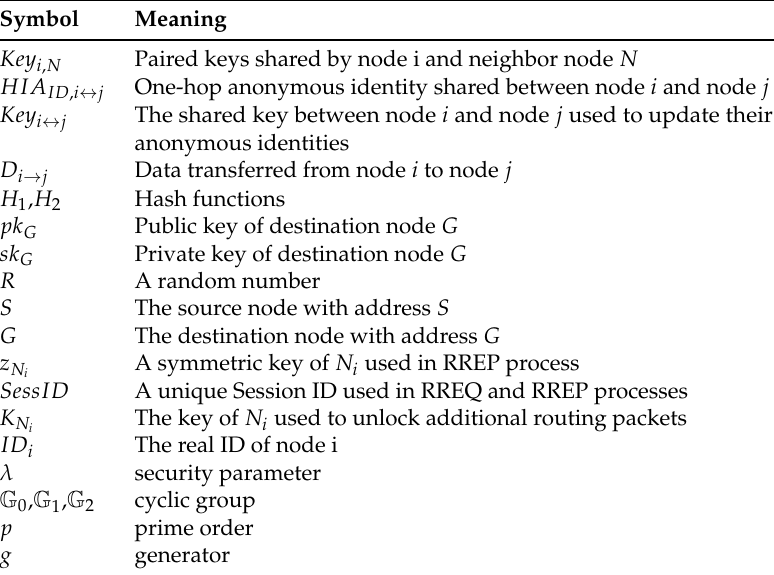
Table 2. Symbols